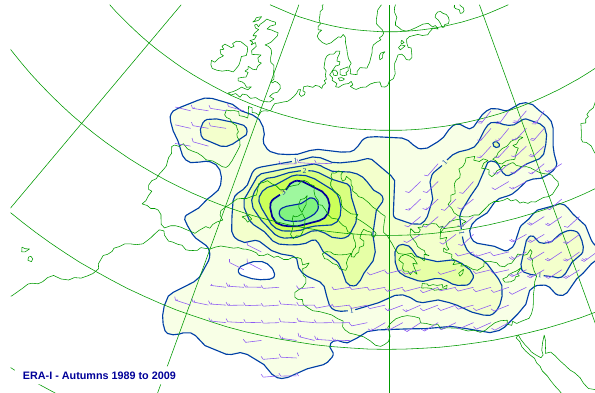
Figure 4. Density of cyclone tracks in autumn. A cyclone location is defined by the 850hPa vorticity maximum. Only cyclones with a vorticity of at least 1 × 10 − 4 s − 1 are considered. The tracking has been made on 1 ◦ resolution lat–lon grid vorticity fields, using ERA-Interim reanalyses, over the 1989–2009 period. The counting is normalised to periods of two months. The arrows are average displacement velocities (barbs, in knots); only average velocities of at least 10kt are plotted; in areas with high cyclone track density, the average becomes lower (courtesy of Bruno Joly, Météo-France; Dee et al.,